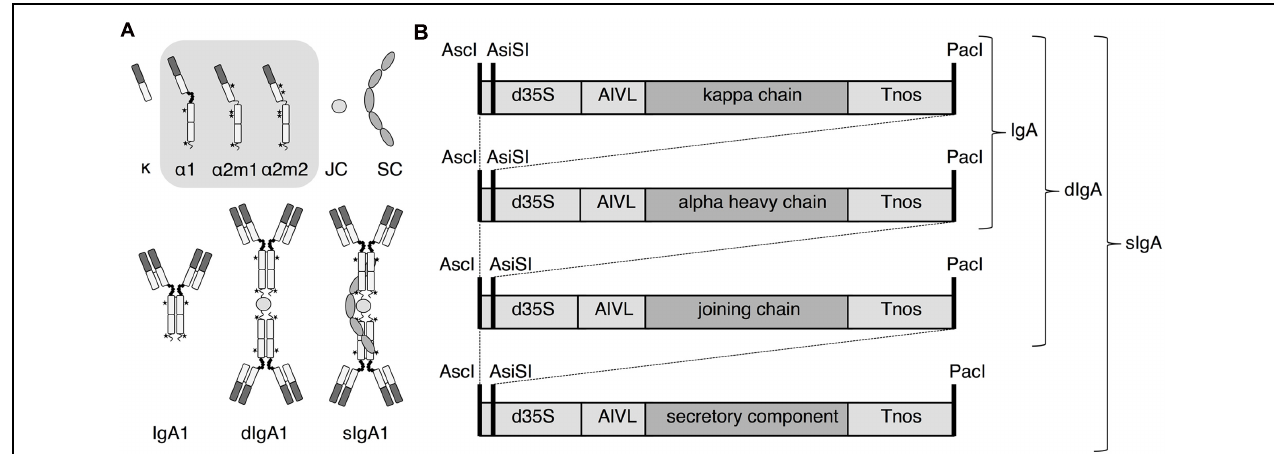
FIGURE 1 | Overview of sIgA assembly and expression. (A) Individual proteins, alpha heavy chain 1 ( α 1 ), 2m1 ( α 2m1 ), or 2m2 ( α 2m2 ), kappa chain ( κ ), joining chain (JC), and secretory component (SC), and protein complexes IgA1 κ , dimeric (d)IgA1 κ and secretory (s)IgA1 κ . (B) Expression cassettes with 35S promoter of the Cauliflower mosaic virus with duplicated enhancer (d35S), Agrobacterium tumefaciens nopaline synthase transcription terminator (Tnos), translational leader sequence of the Alfalfa mosaic virus RNA 4 (AlVL) and AscI, AsiSI and PacI restriction sites are indicated. Co-expression is required for IgA, dIgA, and sIgA assembly as indicated by the